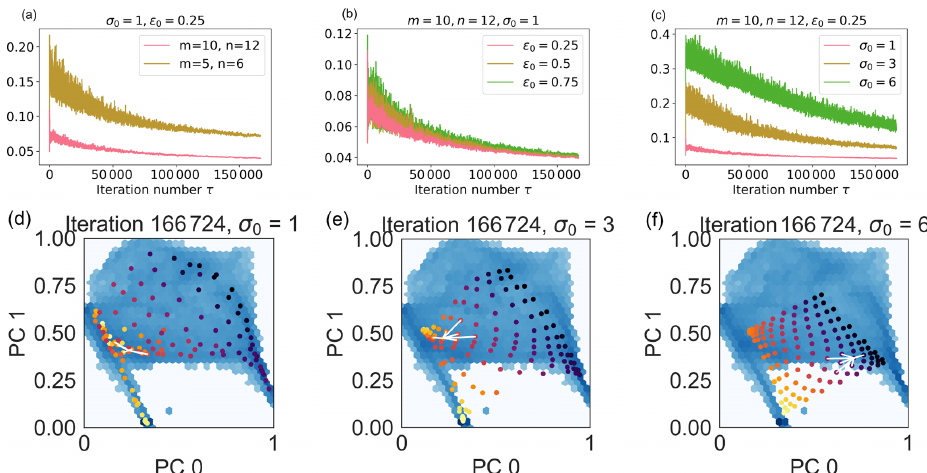
Figure A1. Hyperparameter selection. In panels (a) – (c) , evolution of the quantization error Q E with the number of iterations τ changing the SOM node number ( q ; panel a ), initial learning rate ( (cid:15) 0 ; panel b ), and initial lattice neighbor width ( σ 0 ; panel c ). In panels (d) – (f) , code words 0 and 1 associated with SOM nodes (in bright colors) are superimposed to the input point distribution (blue background) for a SOM with q = 10 × 12 nodes, initial learning rate (cid:15) 0 = 0 . 25, and initial lattice neighbor width σ 0 = 1 (d) , with 3 (e) , and 6 (f) at the final iteration. In the animation, we show the evolution of the node positions with the iteration number. The white lines connect node (3,3) to its nearest